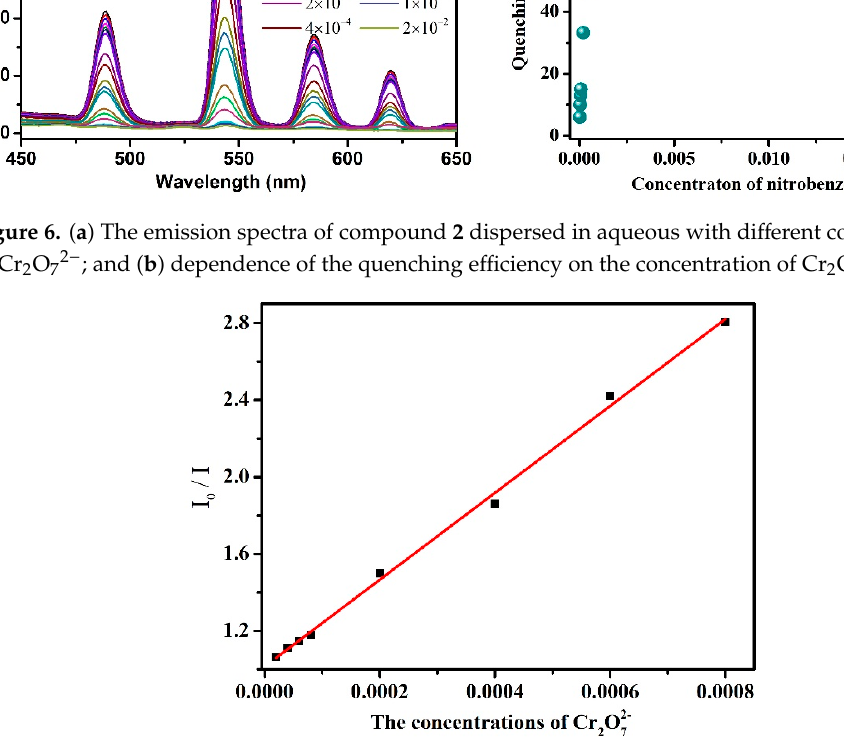
Figure 7. Stern–Volmer plot of compound 2 with different concentrations of Cr 2 O 72 − .